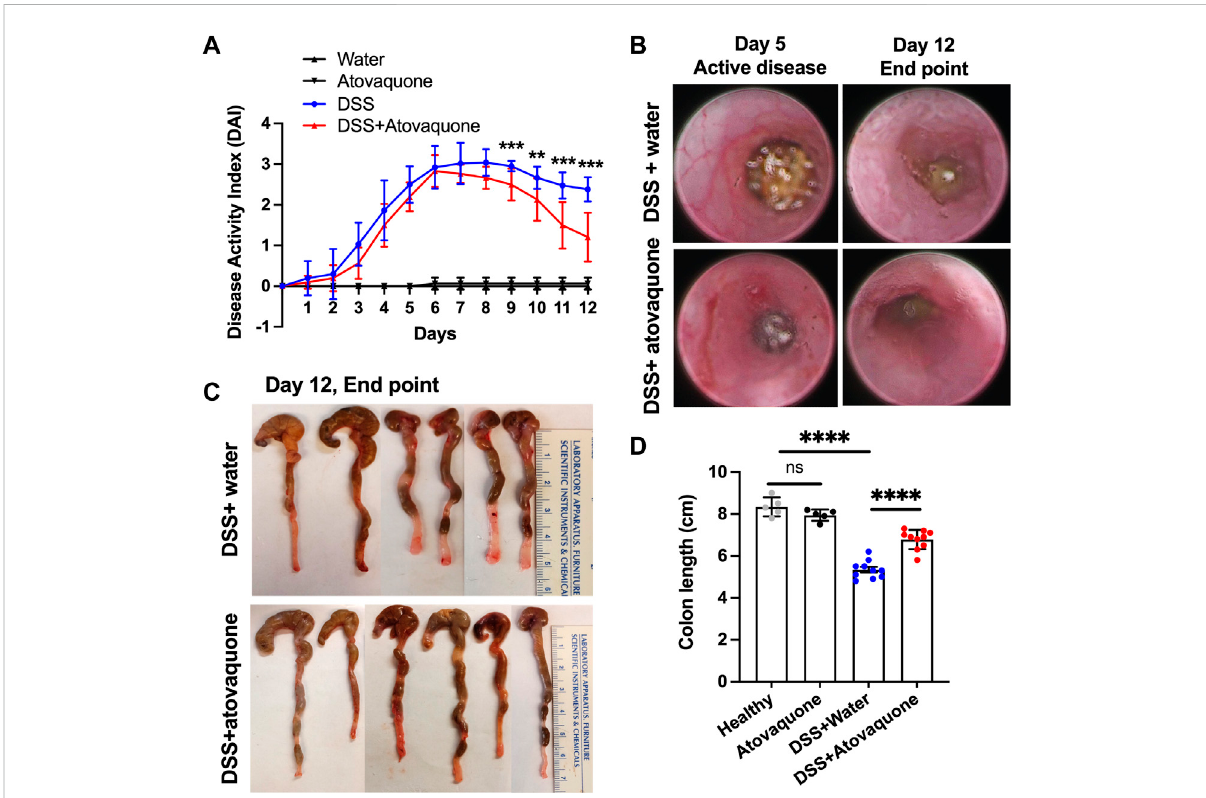
FIGURE 2 Atovaquone treatment promotes resolution of DSS-induced colon injury. (A) Disease Activity Index (DAI) of untreated (blue) or Atovaquone- treated mice (red). N = 2 independent repeats with 5 mice each were analyzed for DSS and DSS + atovaquone conditions. For healthy and atovaquone alone control experiments 5 mice were analyzed. (B) Representative high-resolution colon endoscopy images of untreated (top panel) or atovaquone-treated (bottom panel) mice at active disease (day 5) and end point (day 12). At least 4 mice were scoped per condition. (C,D) Colon length was measured as an index of in fl ammation resolution. (C) Representative images of dissected colons and (D) Quanti fi cation of colon length (cm) in untreated (top panel) versus atovaquone-treated (bottom panel) animals. N = 2 independent repeats with 5 mice each were analyzed for DSS and DSS + atovaquone conditions. For healthy and atovaquone alone control experiments 5 mice were analyzed. ** p < 0.01, *** p < 0.001, **** p < 0.0001, ns, not signi fi